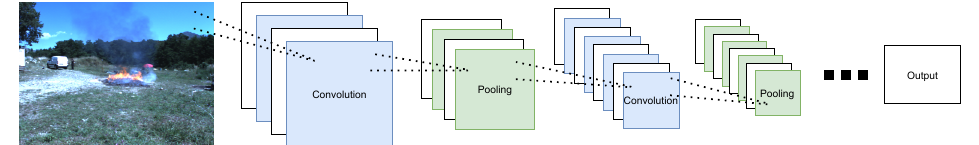
Figure 2. Sample basic architecture of a CNN. The last layers can differ depending on the particular application (e.g., classification, segmentation,